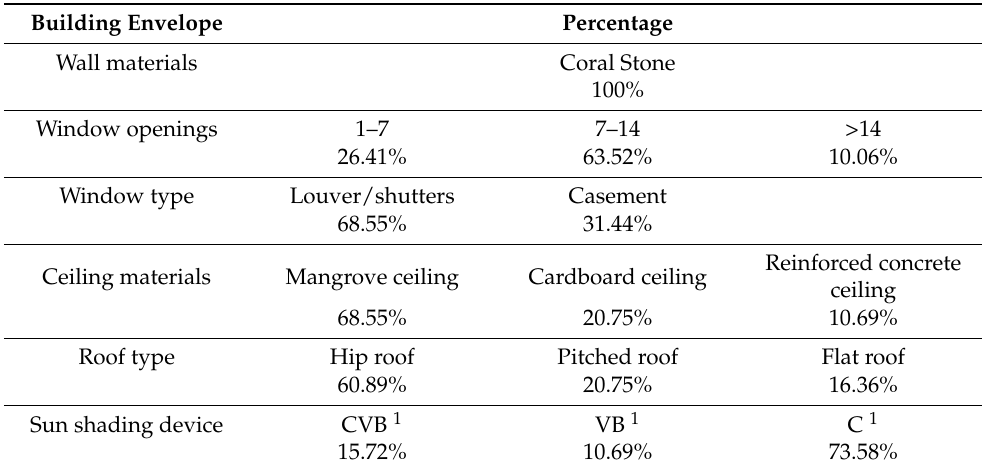
Table 1. Results of the building envelope